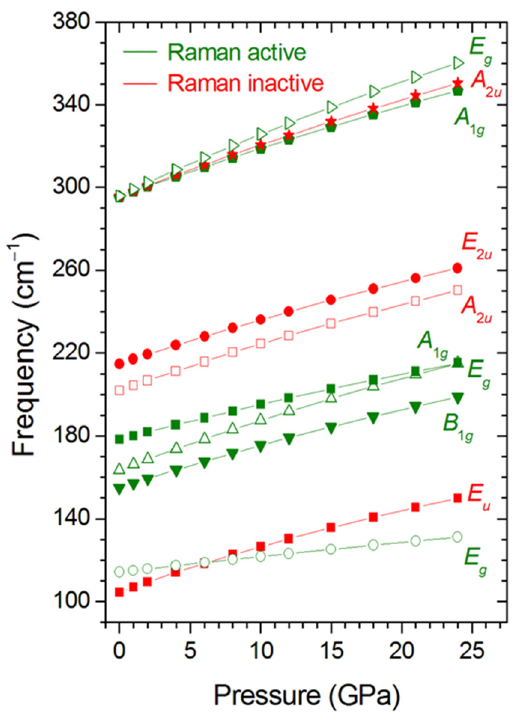
Figure 3. Frequency of the zone-center phonon modes of RhNiAs as a function of hydrostatic pressure.